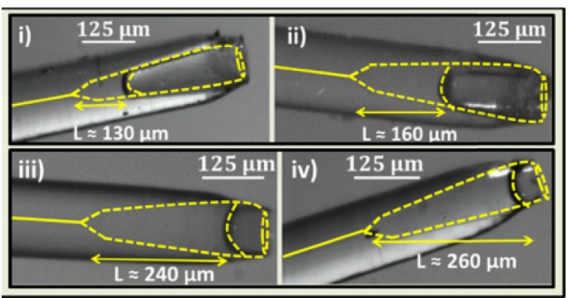
Figure 7. FPI-based PDMS-filled micro-cavity for temperature sensing. Inset shows micrographs of micro-cavity lengths of ( i ) 130 µ m, ( ii ) 160 µ m, ( iii ) 240 µ m and ( iv ) 260 µ m, respectively. Reproduced with permission from Ref. [97], Optica Publishing Group Copyright